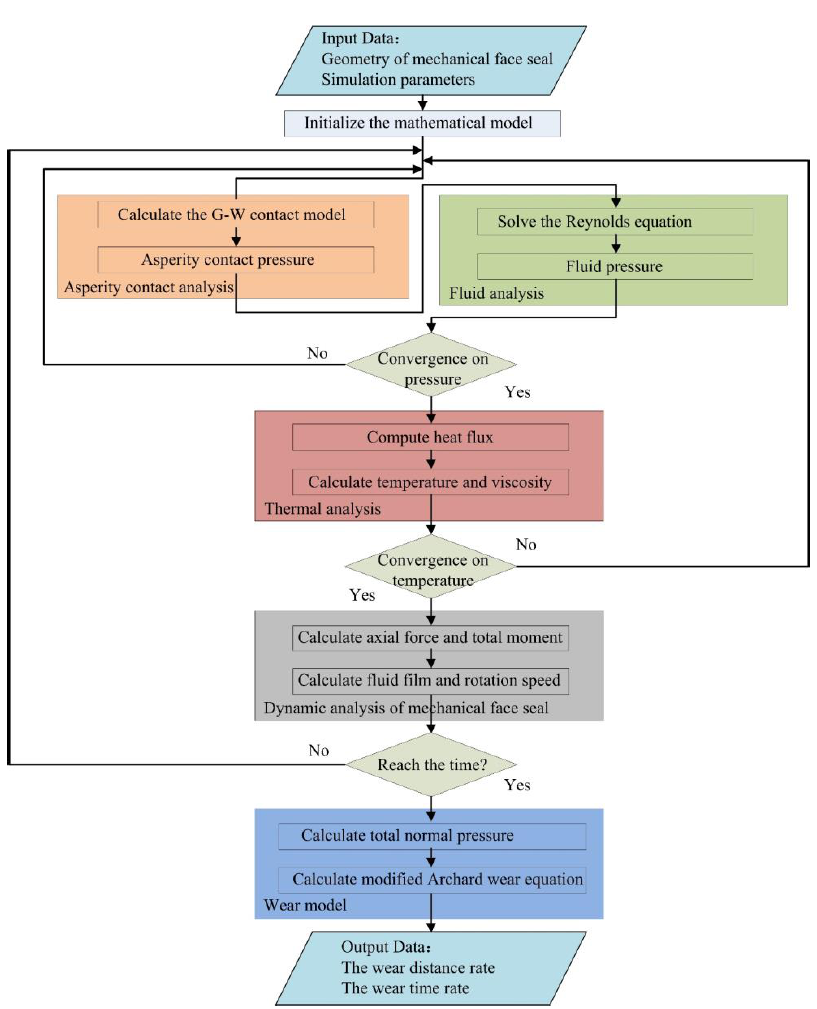
Figure 5. Flowchart of the proposed wear simulation method.